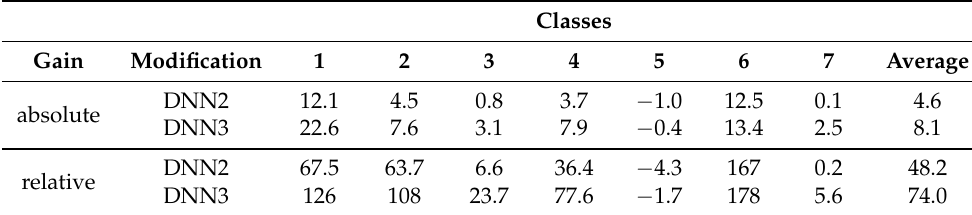
Table 1. The absolute and relative gain for each class of the objects after first and second dataset modification